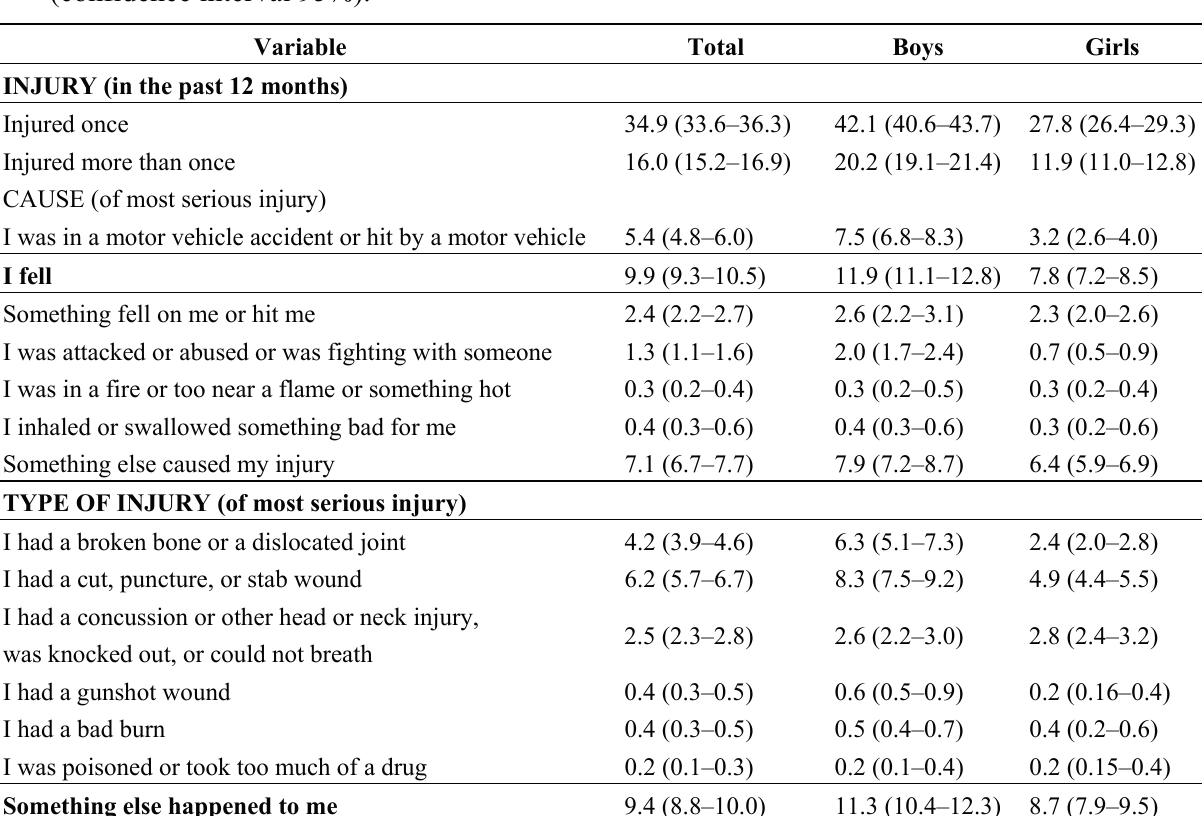
Table 3. Annual prevalence of injury events, cause and type of injury by sex in percent (confidence interval 95%).